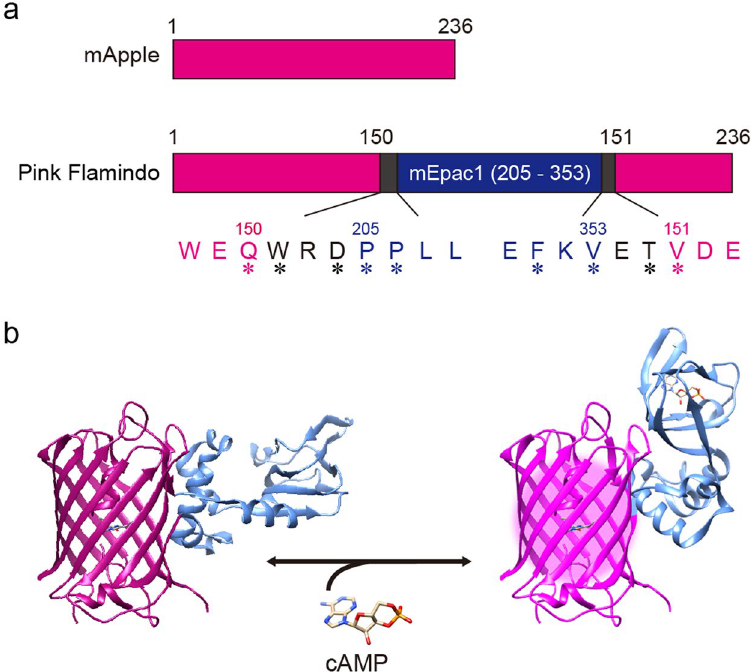
Figure 1. Schematic of the structure of Pink Flamindo. ( a ) Drawings for mApple and resultant Pink Flamindo. Asterisks indicate mutations. ( b ) 3D representation of Pink Flamindo bound (right) and unbound (left) to cAMP. Images were created using structural graphics from mCherry (PDB_4ZIO), which has the same origin of gene as mApple and Epac1 (cAMP-unbound: PDB_2BYV, cAMP-bound: